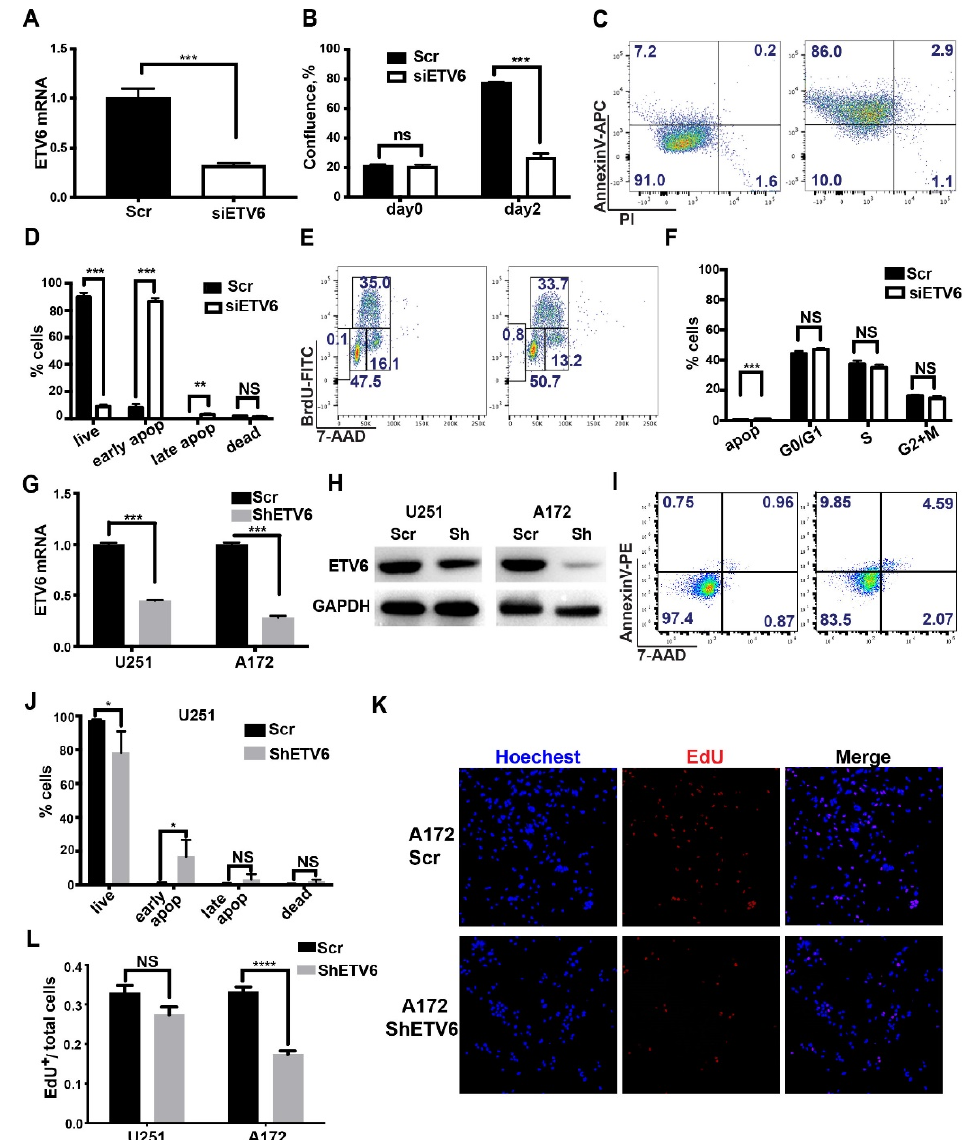
Figure 2. ETV6 knockdown led to increased apoptosis and decreased proliferation in GBM cell lines. ( A ) ETV6 knockdown efficiency reached 70–80% in siETV6 transfected U251 cells, as determined by qRT-PCR. ( B ) Cell confluence was significantly decreased in siETV6 transfected U251 cells as monitored by IncuCyte. ( C ) Control or siETV6 transfected U251 cells were stained with AnnexinV-APC and PI for apoptotic analysis. Representative flow images are shown. ( D ) Quantification showed that ETV6 knockdown led to decreased survival and increased early and late apoptosis. ( E , F ) Cell proliferation and cell cycle were minimally affected in siETV6 transfected U251 cells, as revealed by BrdU-FITC and 7-AAD flow cytometric analysis. Representative images ( E ) and quantification of cell ratios in different phases of cell cycle are shown ( F ). ( G , H ) Knockdown efficiency of shETV6-infected U251 and A172 glioma cells was determined by qRT-PCR and Western blot, respectively. GAPDH was used as the internal control. ( H ) was cropped from original files named “ETV6 gel” and “GAPDH gel”. ( I , J ) Scramble or shETV6-infected U251 cells were stained with AnnexinV-PE and 7-AAD for apoptotic analysis. Representative flow images ( I ) and quantification ( J ) are shown. Consistently, ETV6 knockdown by shRNA led to increased early apoptosis and decreased survival in U251 cells. ( K , L ) EdU assay revealed that shETV6-infected A172 cells had decreased DNA synthesis but not shETV6-infected U251 cells. Scale bar, 100 μ m (*, p < 0.05; **, p <0.01; ***, p < 0.001; ****, p < 0.0001; NS, not significant).